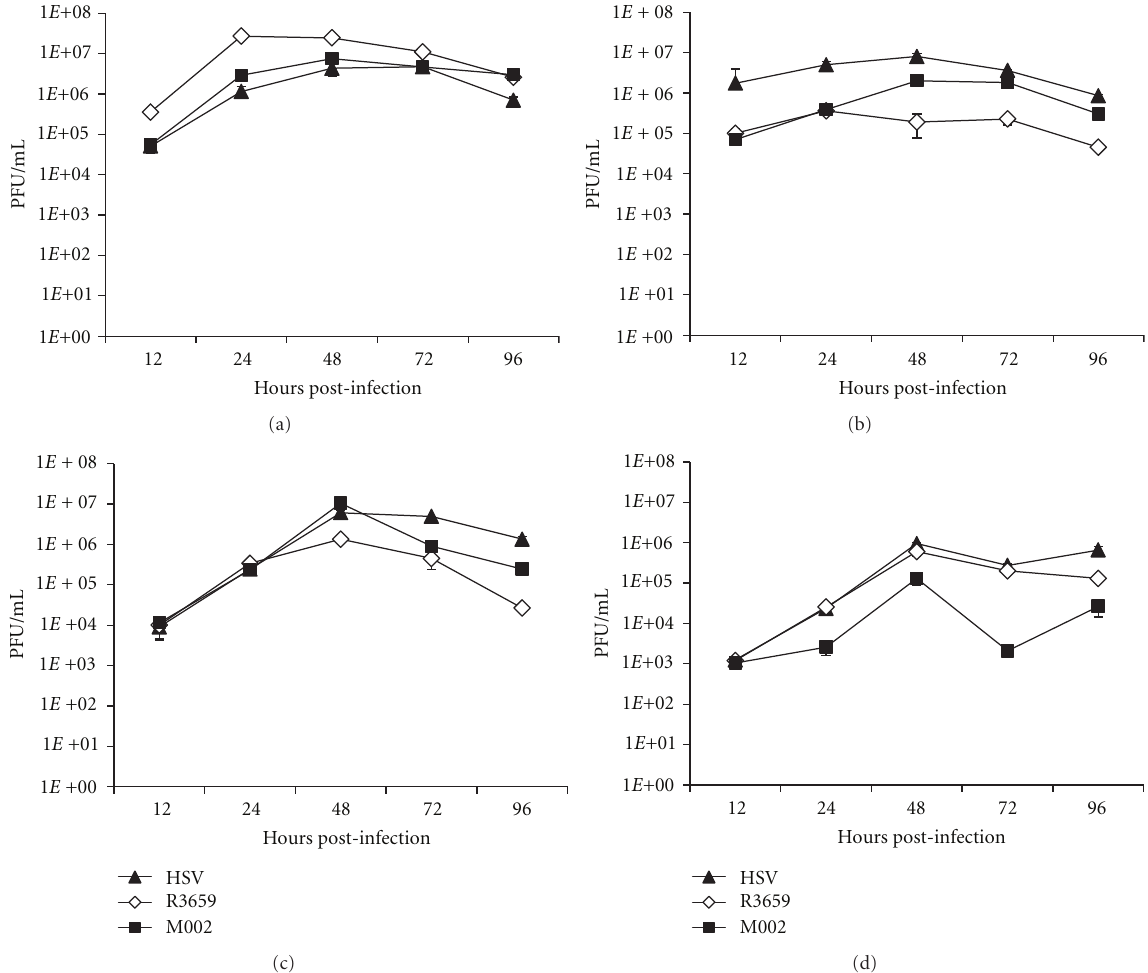
Figure 3: Replication of M002 over time. In a multistep replication assay, HSV replication was assayed in the following lines: the permissive Vero cell line (a), human breast cancer MDA-MB-361 (b), and murine mammary carcinoma lines SCK (c) and 4T1 (d). Cells were infected with HSV-1 (F) (triangles), R3659 (diamonds), and M002 (boxes) at an MOI of 0.1 PFU/cell. At multiple time points, cells and media were harvested, and viral replication was assayed by titration on Vero cell